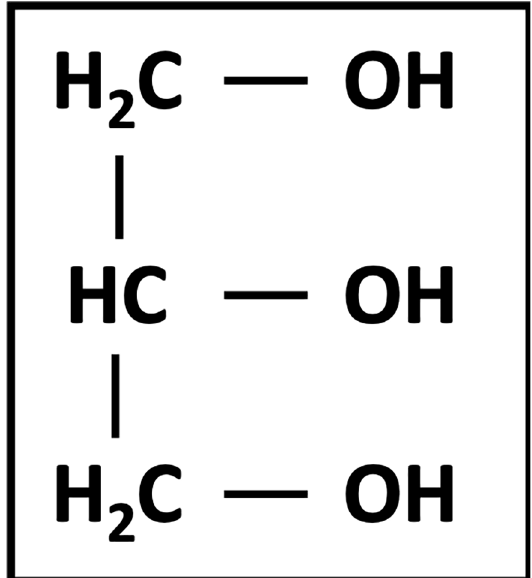
Figure 1. Molecular structure of